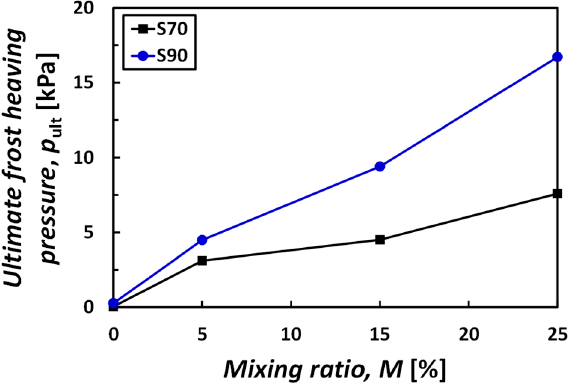
Figure 8. Summary of frost heaving pressure tests.